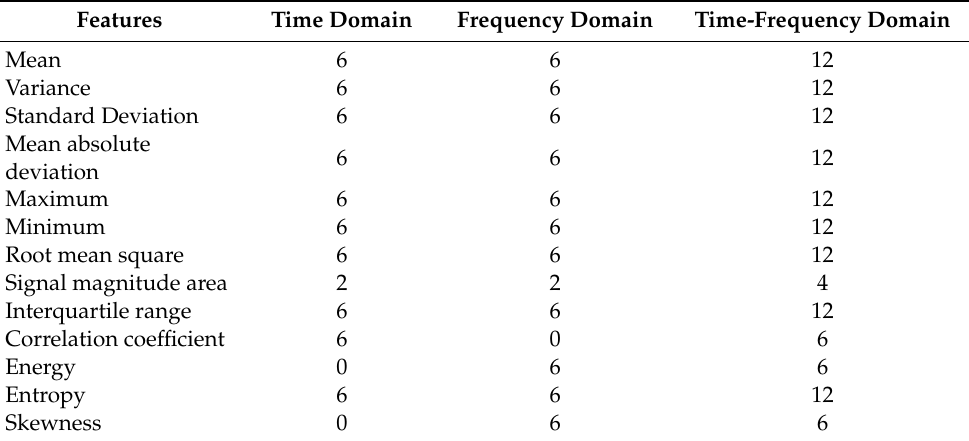
Table 3. List of computing feature vector for statistical